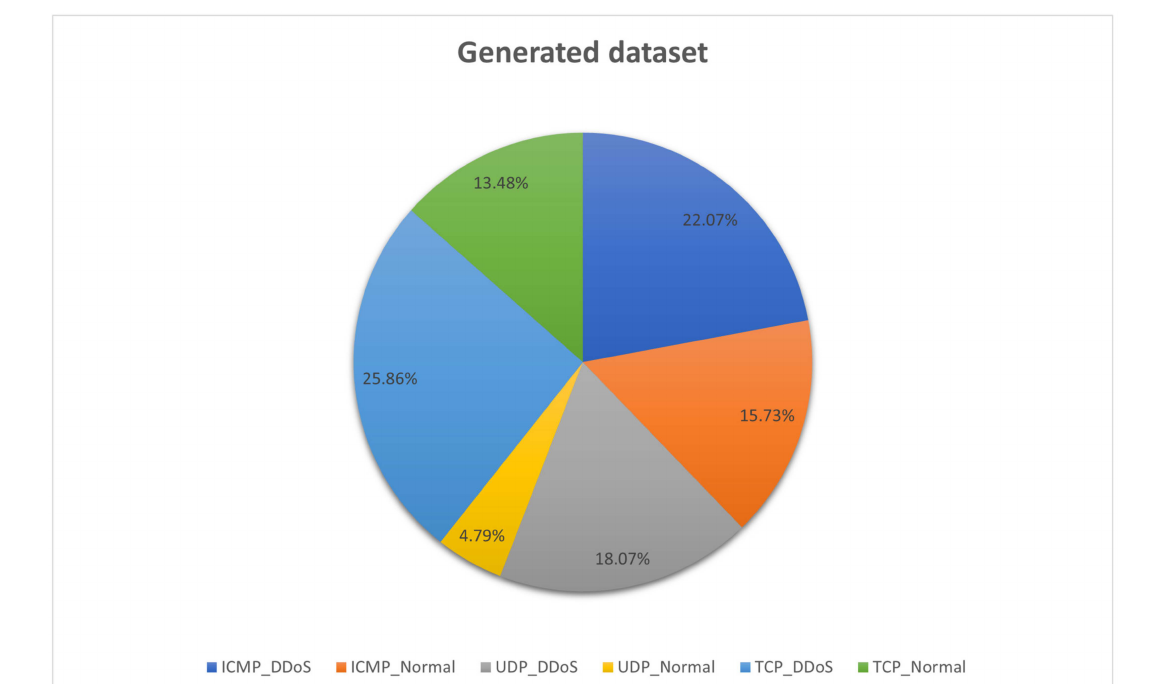
Figure 2. The percentage of traffic types of generated dataset.